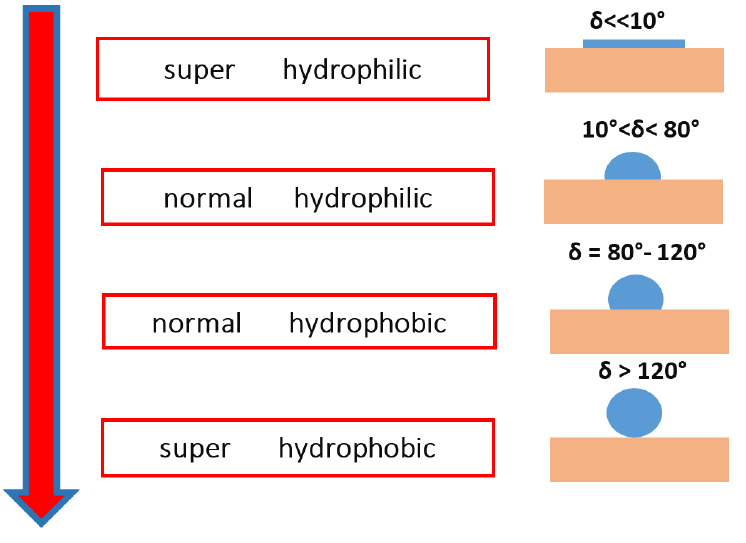
Figure 1. Hydrophilic and hydrophobic surfaces [9].